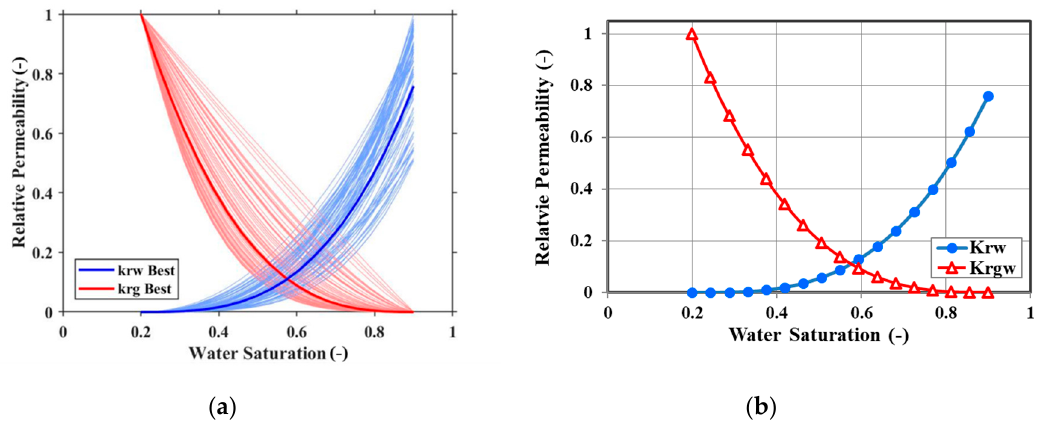
Figure 6. Relative permeability curves for the shale gas simulation with the two-phase flow: ( a ) the uncertainty distribution obtained from the AHM [24]; and ( b ) the best match result extracted from all the realizations of